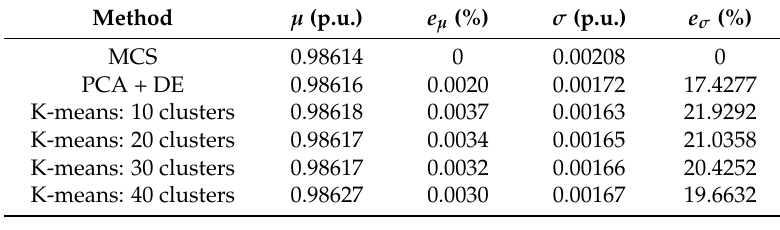
Table 4. Comparison of results from different methods for voltage at bus 16.